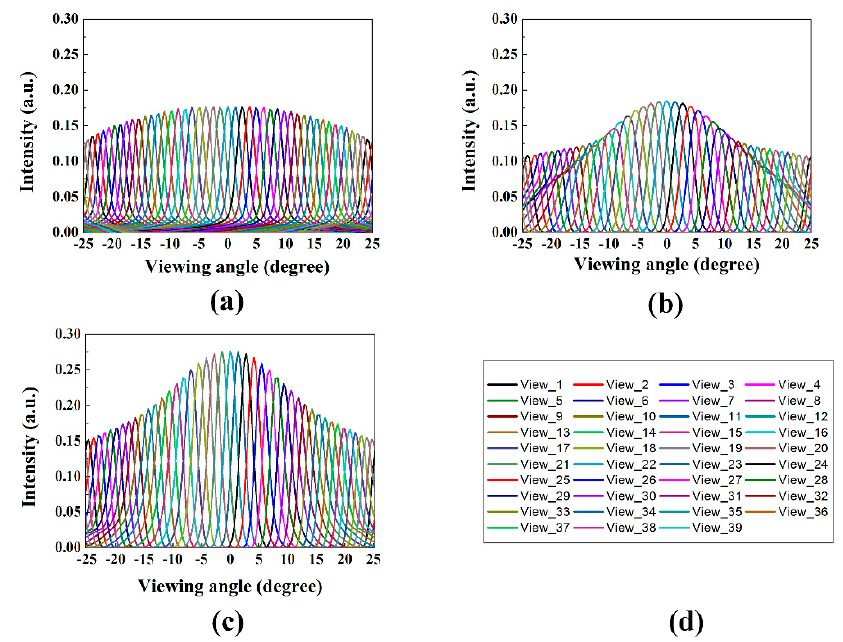
Figure 10. Simulation results showing the viewing distribution of the QHD (750.6 ppi) mobile panel in the autostereoscopic multi-view (43-view) 3D mode by the polarization-dependent-switching high- ∆ n LC GRIN lens array with ( a ) spherical, ( b ) quadratic polynomial aspherical, and ( c ) high-order (fourth-order) polynomial aspherical curvatures. ( d ) View-numbering in Figure. 10a–10c.